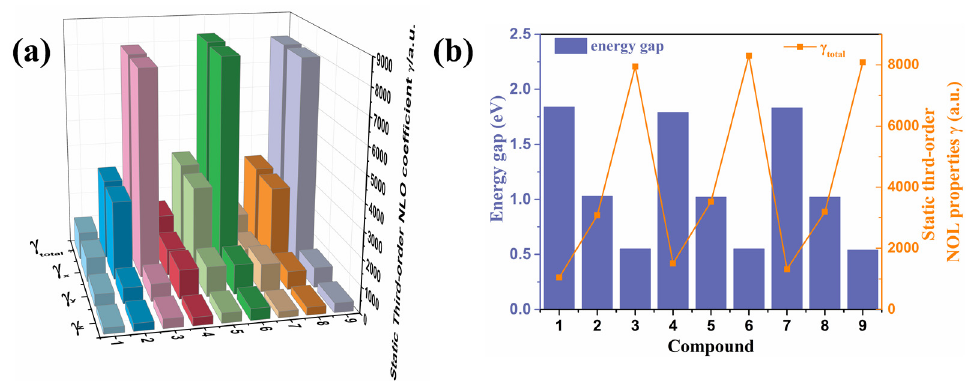
Table 2. Calculated static and dynamic second hyperpolarizability ( γ ).